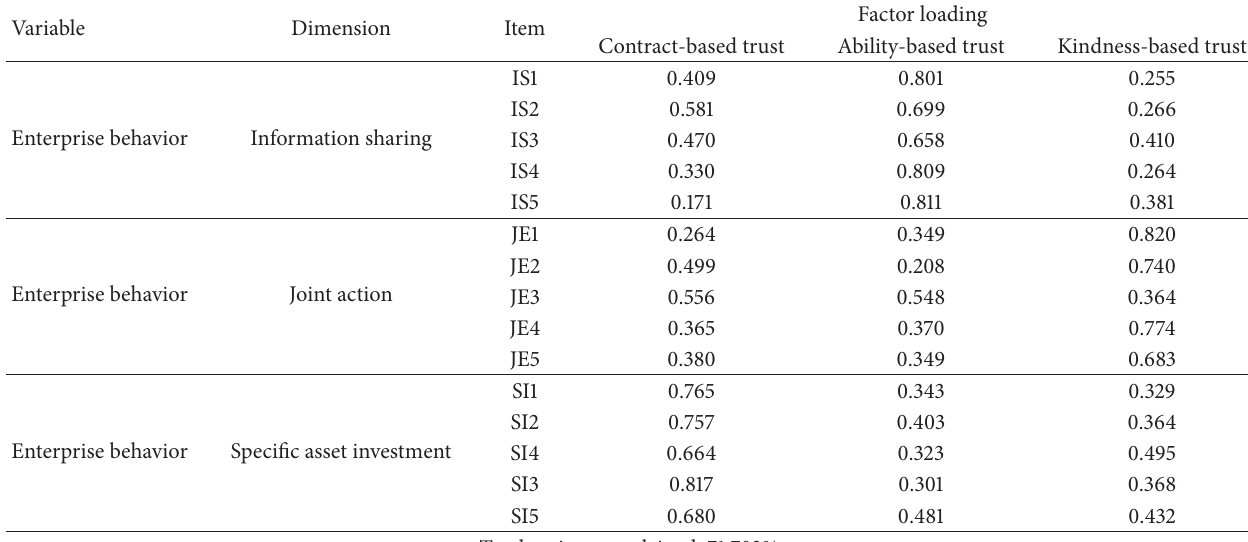
Table 12: The factor analysis results of enterprise